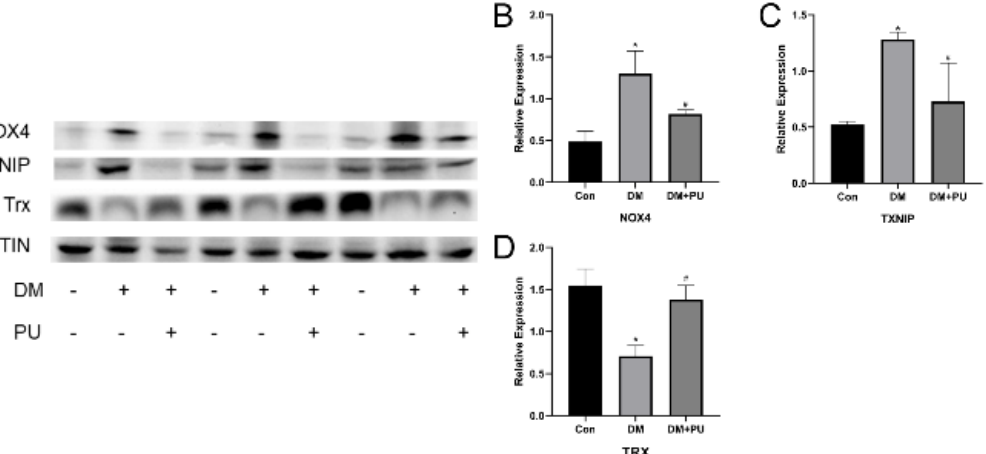
Figure 4. Effects of PU on the high glucose-induced inflammasome signaling pathway. ( A ) The results of NOX4, TXNIP, and Trx by Western blot. ( B ) Protein expression levels of NOX4 by WB. ( C ) Protein expression levels of TXNIP by WB. ( D ) Protein expression levels of Trx by WB. The relative expression is expressed by the ratio of the target protein to β -actin. * p < 0.05 vs. Con group; # p < 0.05 vs. DM group.